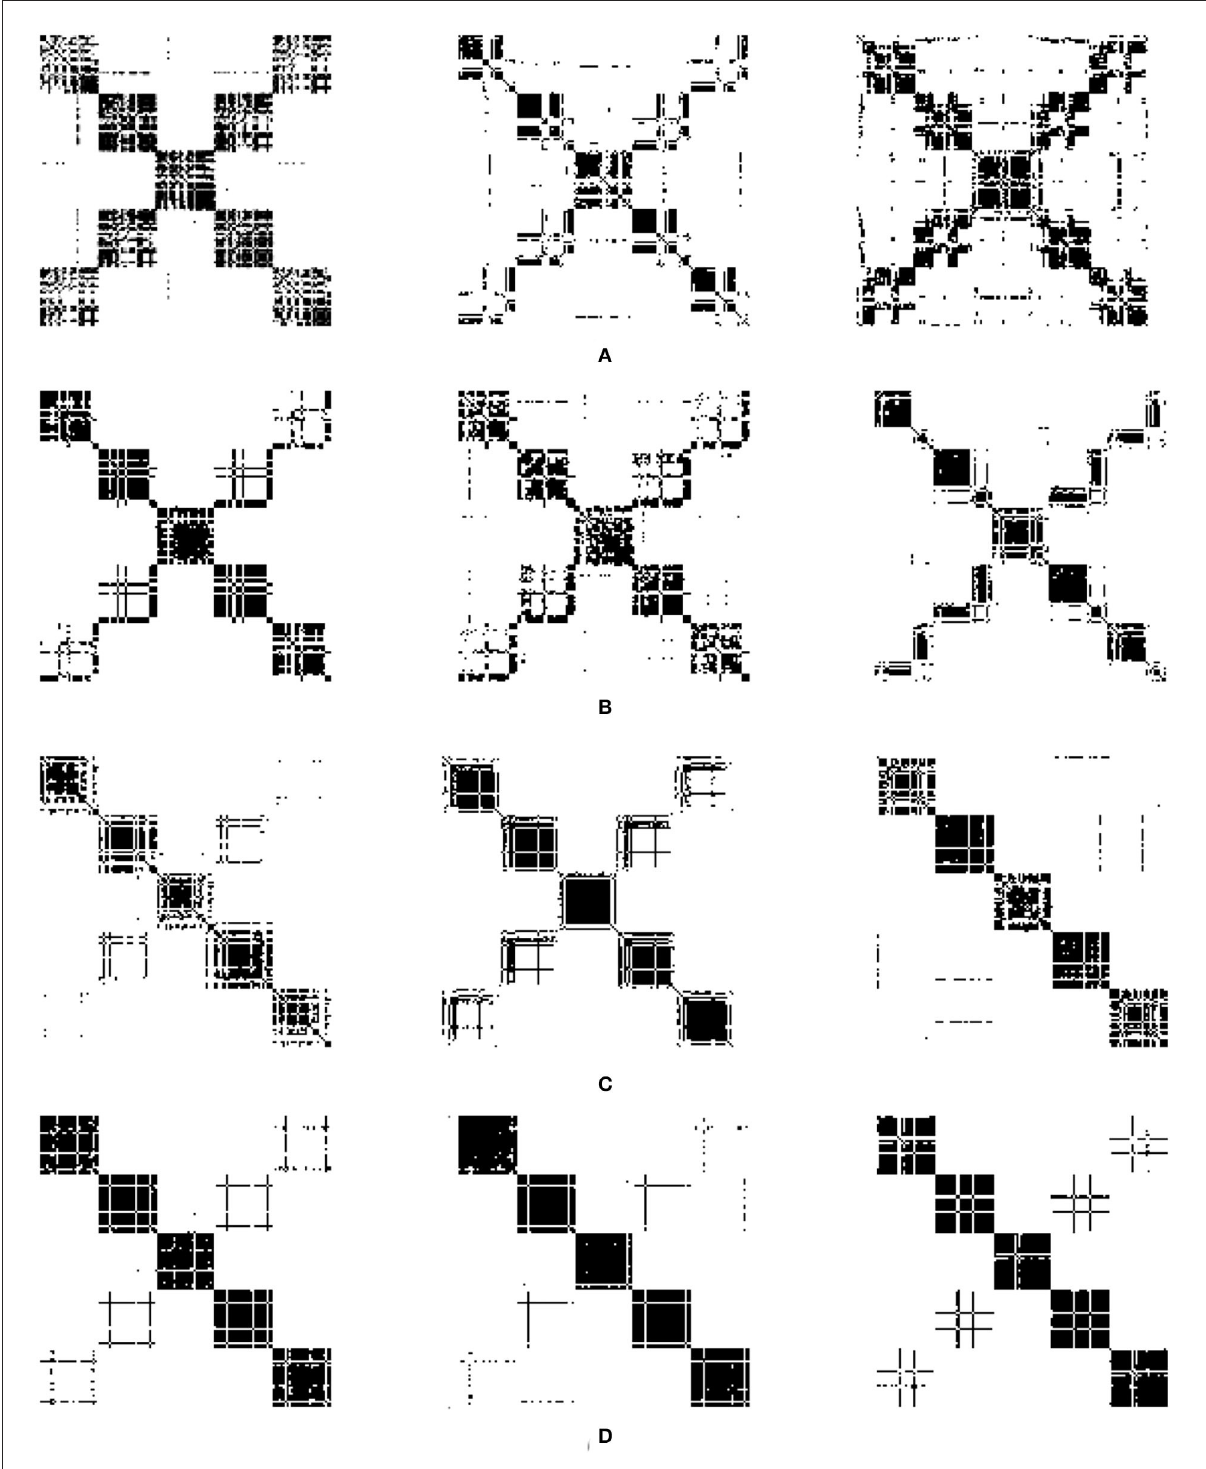
FIGURE4 RPs of fNIRS dataset. (A) 0-back, (B) 2-back, (C) 3-back, (D)